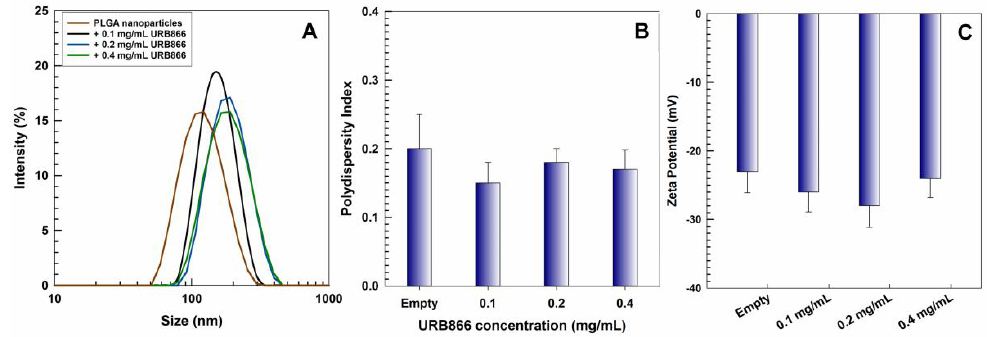
Figure 2. ( A ) Mean size, ( B ) polydispersity index and ( C ) zeta potential of PLGA nanoparticles as a function of the molecule concentration.